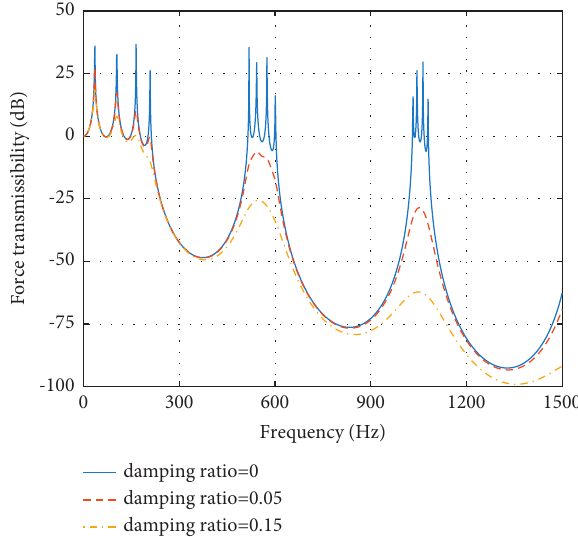
Figure 15: Force transmissibility of PSPS with different damping loss factors under